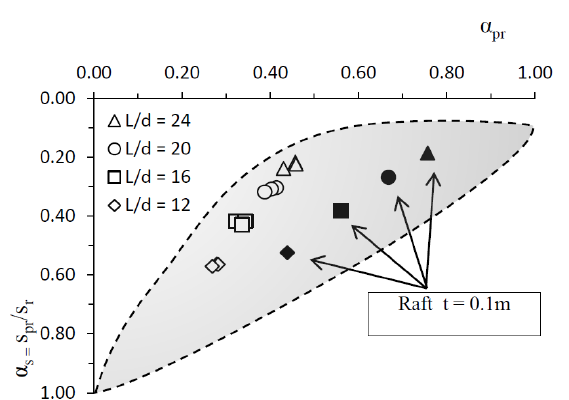
Figure 27. Evaluation of settlement reduction and load sharing for the piled rafts (at 50% of Q max ).